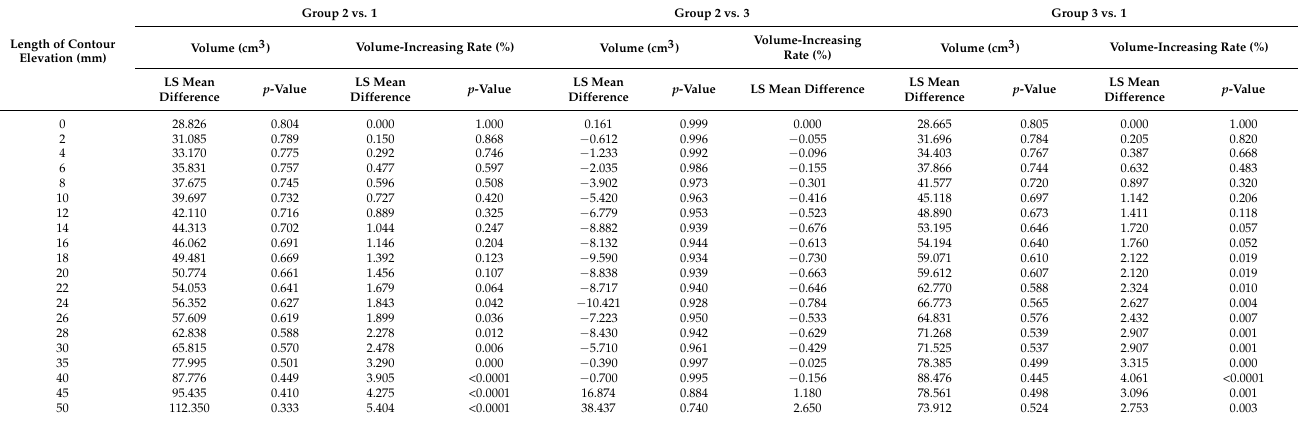
mean changes in the volume and the volume-increasing rate were observed in Group 3, compared to Group 2 (indicated by an arrow, Figure 7A,B). Table 7. Comparison of the effects of contour elevation on volume expansion between Groups